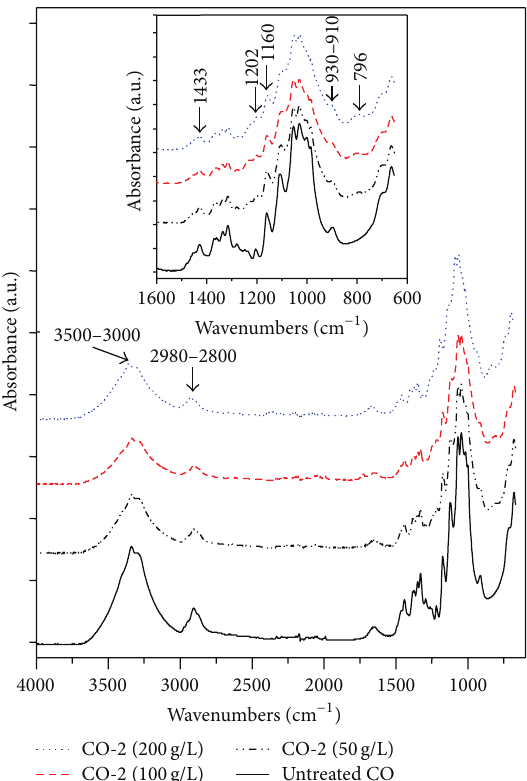
Figure 3: ATR FT-IR spectra of untreated cotton and treated cotton samples with GPTMS at 50g/L, 100g/L, and 200